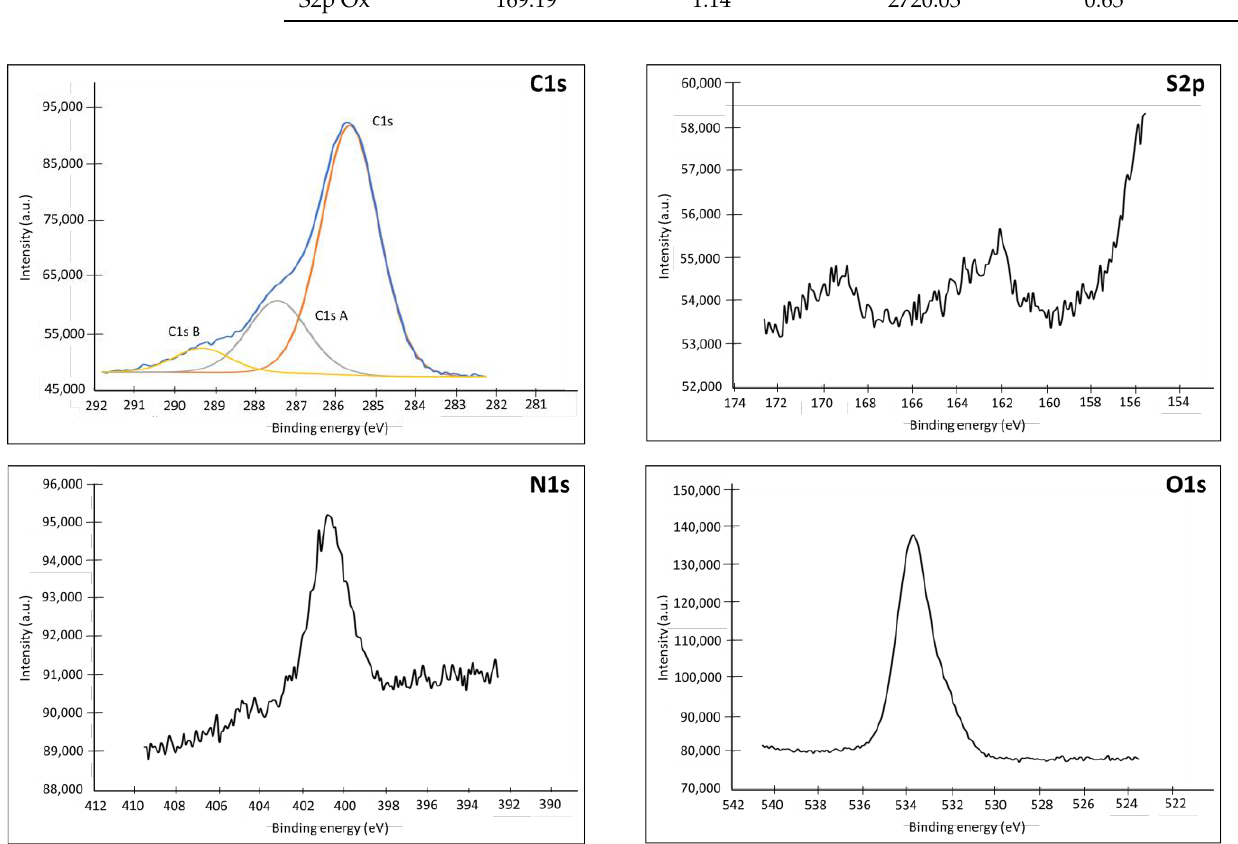
Figure A5. XPS spectra (C1s, S2p, N1s, O1s) of an Au plate electrode modified with Product 7. FTIR